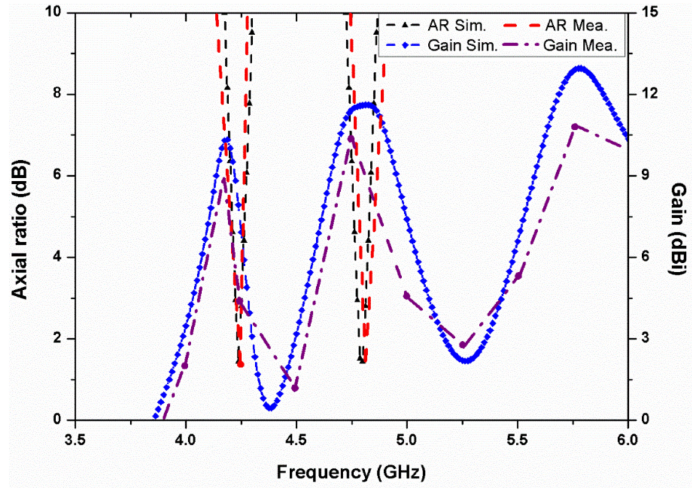
Figure 12. Simulated and measured axial ratio and gain of the four-element stacked MIMO antenna. The ECC of the proposed four element stacked MIMO antenna is negligibly small and is plotted in Figure 13. The ECC values are less than 0.05 at the three resonating bands, which assures that the MIMO antenna exhibits good diversity performance. Furthermore, the antenna diversity gain (DG) is evaluated, and it is noticed that the value of DG is greater than 9.9 dB, as can be seen in Table 2. The radiation patterns of the proposed stacked antenna at 4.2 and 4.8 GHz are shown in Figure 14. It can be seen that the antenna radiates LHCP waves in the + Z -direction and right-hand circularly polarized (RHCP) waves in the – Z -direction when port-1 is excited and other ports are matched.